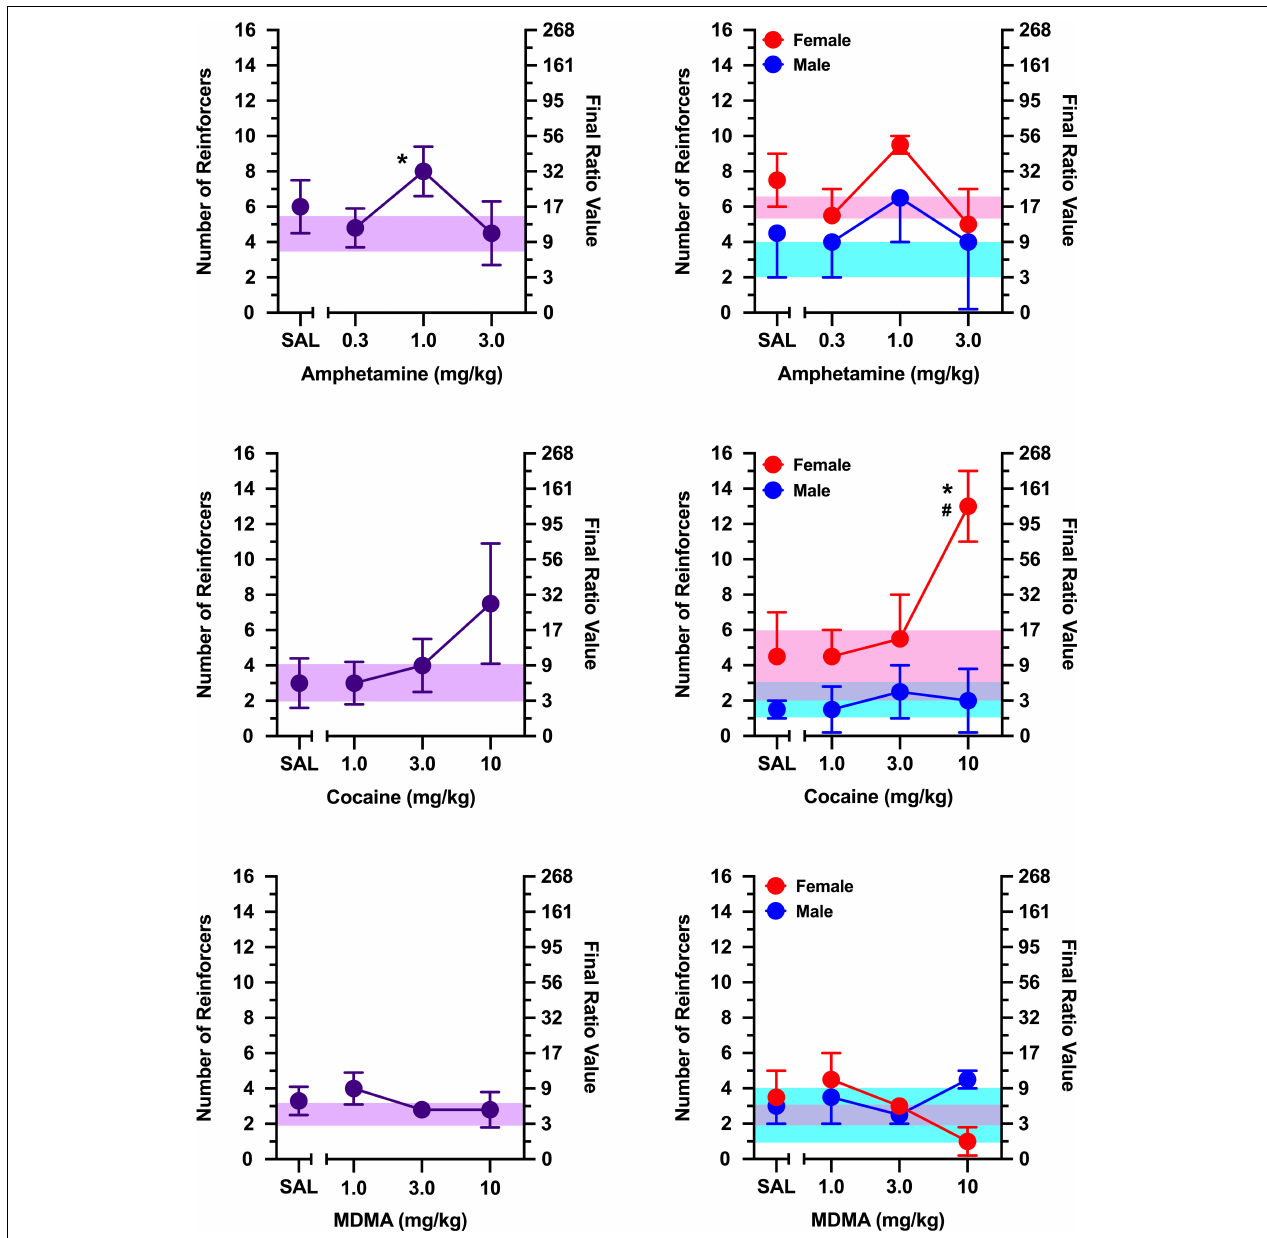
FIGURE 5 | The effects of d -amphetamine (top) , cocaine (middle) , and MDMA (bottom) on breakpoints maintained by a non-social stimulus (i.e., black-and-white athletic sock). Left panels depict data collapsed across males and females. Right panels depict data collected in males and females separately. Left axes reflect breakpoint defined as the number of reinforcers obtained; right panels depict breakpoint as final ratio value completed. Bottom axes represent the effects of saline (SAL) and doses of d -amphetamine, cocaine, and MDMA expressed in mg/kg. Asterisks (*) indicate significant difference relative to saline. Number sign ( # ) indicates significant difference relative to male rats. Shaded regions indicate variance in breakpoint during non-injection control sessions (purple = collapsed across sex; blue = male; pink =